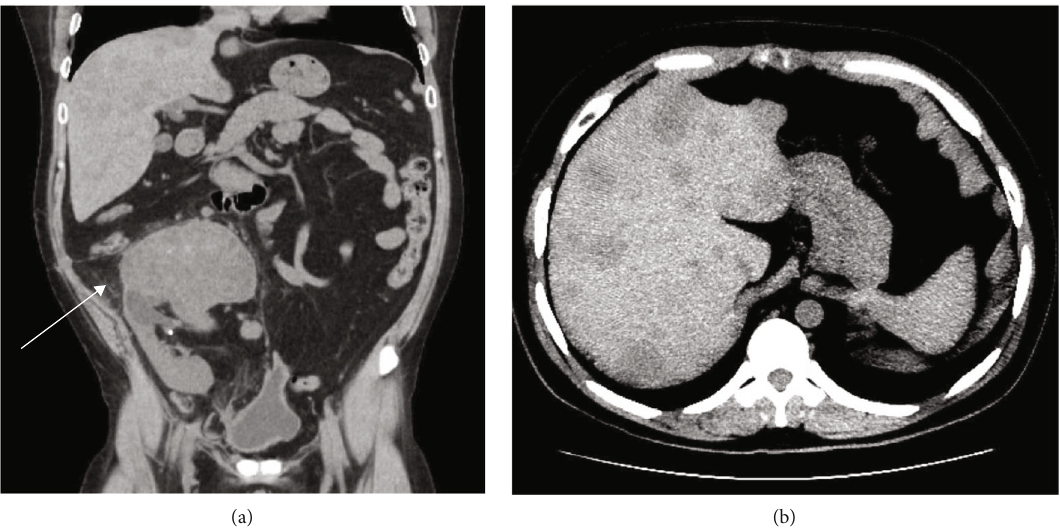
Figure 1: (a) For case 1, coronal view of computer tomographic scan without intravenous contrast visualized 11 cm mass in the renal allograft (arrow). Multiple hypodense masses were vaguely present in the liver. (b) Axial view of the same scan with di ff erent brightness and contrast setting visualized numerous hypodense masses in the